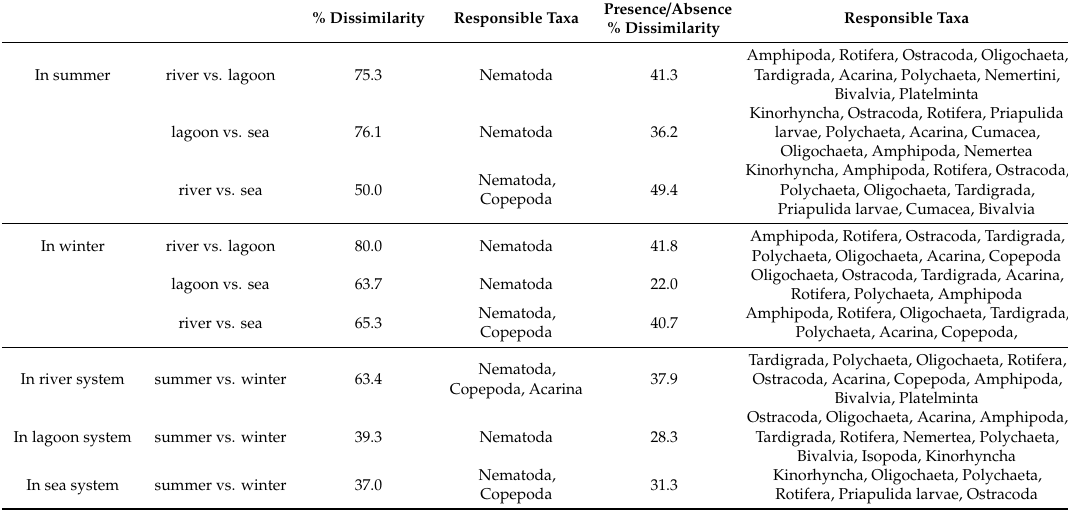
Table 2. Output of SIMPER analysis (cut o ff 90%), testing for % dissimilarity among systems in each season and between seasons in each system. %